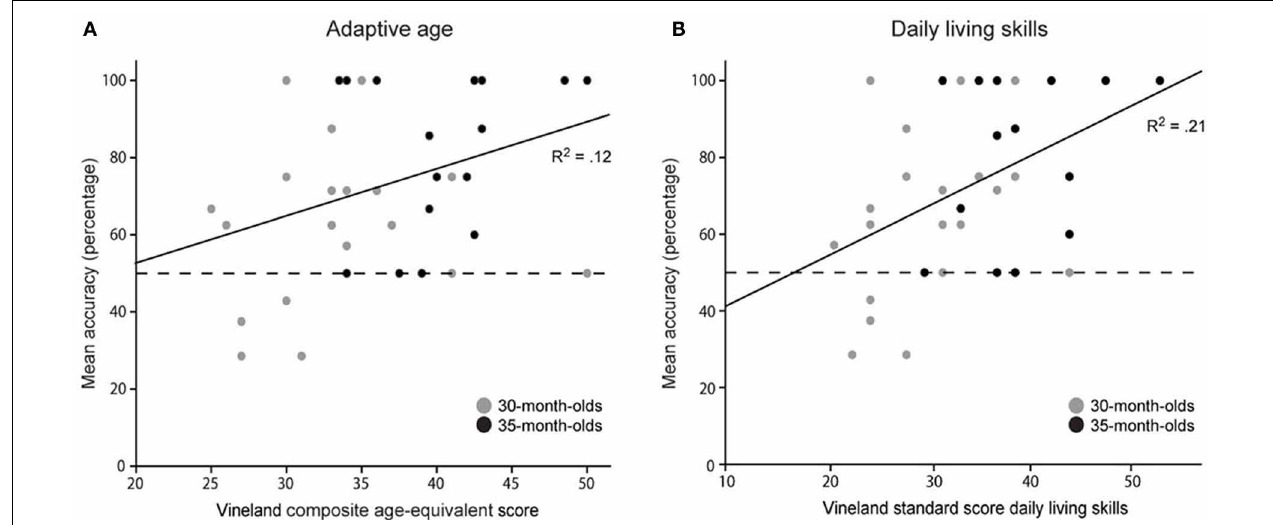
FIGURE 5 | Individual spatial task performance on non-distracting trials (i.e., beach and square environments). Scatter plots indicating linear correlations between (A) Vineland composite age-equivalent score and mean accuracy, and (B) Vineland standard score daily living skills and mean